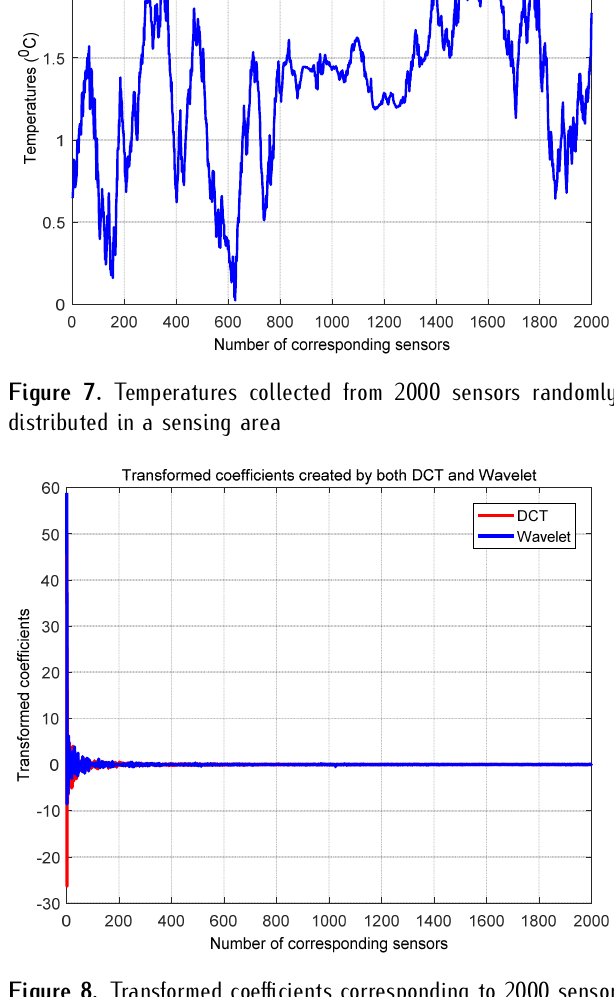
Figure 8. Transformed coefficients corresponding to 2000